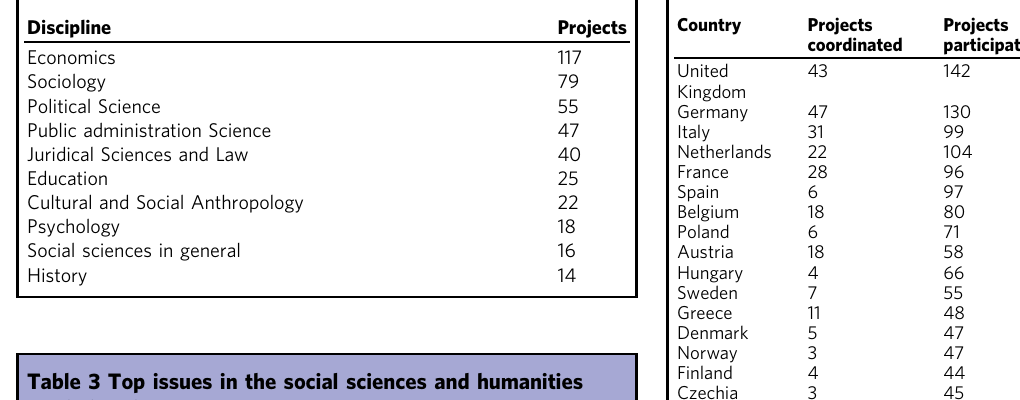
Table 2 Top ten disciplines in the social sciences and humanities funded under FP6.